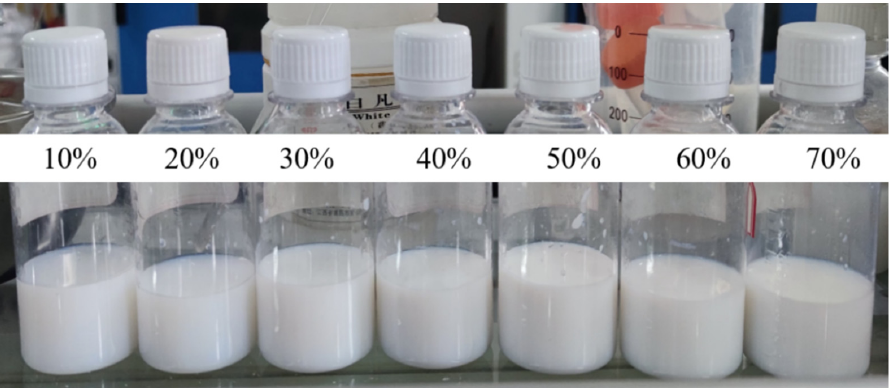
Figure 1. The milky white fluorinated nano-emulsions with fluorinated monomer mass ratios from 10 wt% to 70 wt% after being stored for 30 d.